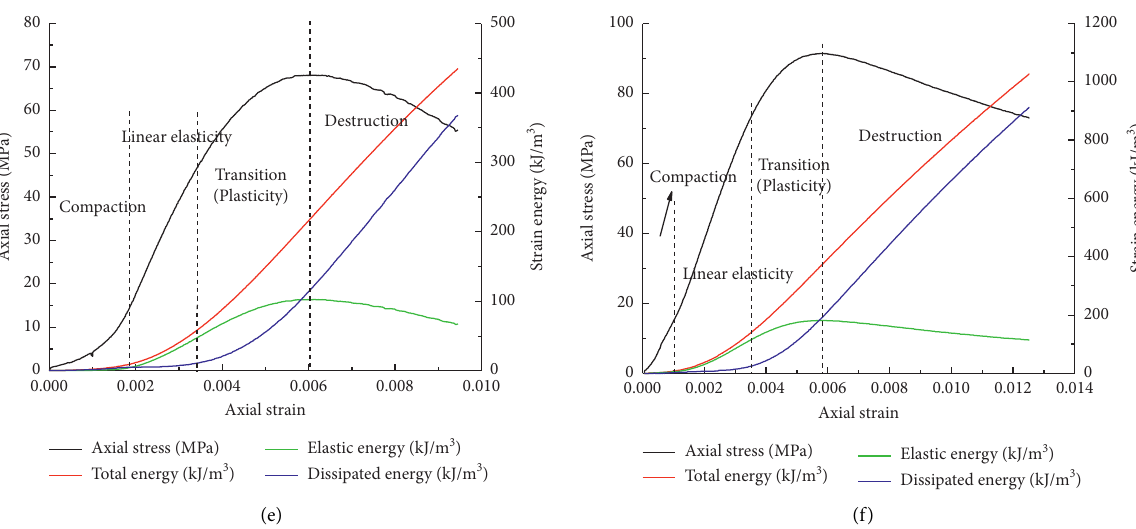
Figure 6: The relationship between strain energy and axial strain under different confining pressures: (a) group A samples under 4MPa confining pressure, (b) group A samples under 8MPa confining pressure, (c) group B samples under 4 MPa confining pressure, (d) group B samples under 8MPa confining pressure, (e) group C samples under 4MPa confining pressure, and (f) group C samples under 8MPa confining pressure.